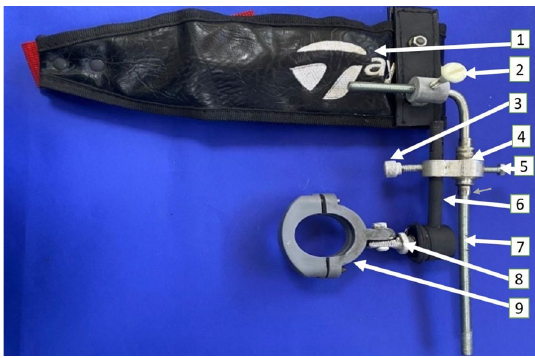
Fig. 5 Microscope Holding Device (MHD Device) Consists Of (1) Headband (2) Stabilizing Joint, (3) Fixing Joint, (4) Mounting Bar, (5) Mounting Screw (6) Vertical Positioning Arm (7) L-shaped metal support, (8) Ball and Socket Joint, (9) Microscope Locator